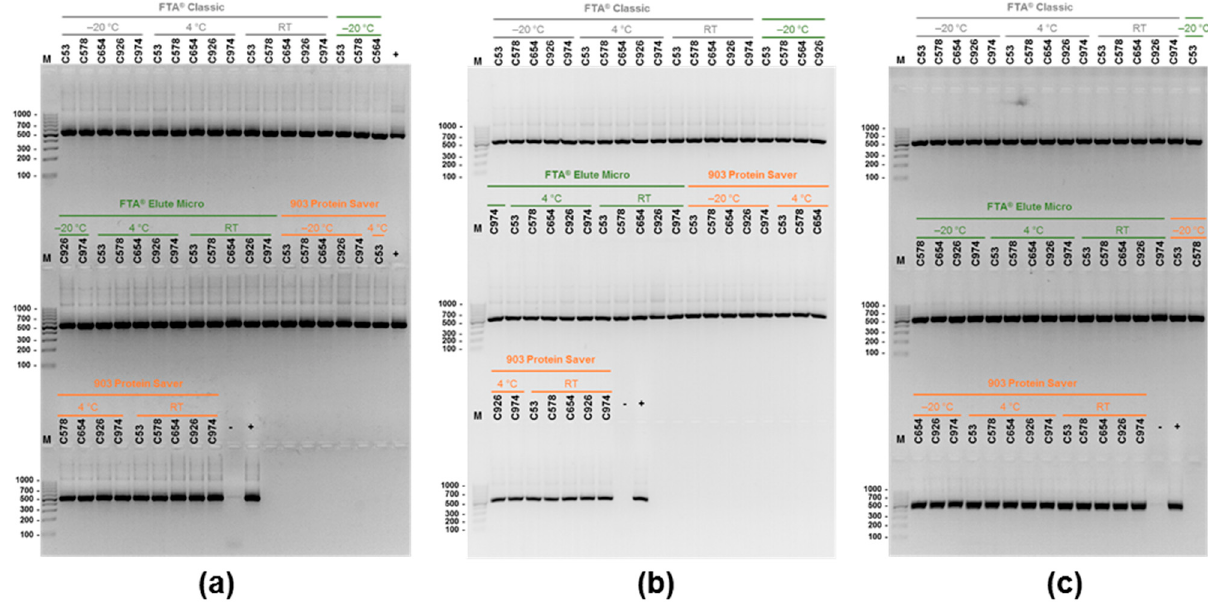
Figure 3. Agarose gel electrophoresis (2% w / v ) detection of PCR products showing the presence of a 587-bp amplicon for the Cryptosporidium hominis ssu rRNA gene extracted from the three Whatman ® cards evaluated in the present study at different storage conditions. ( a ): 1 month-length storage; ( b ): 3 months-length storage; ( c ): 6 month-length storage.